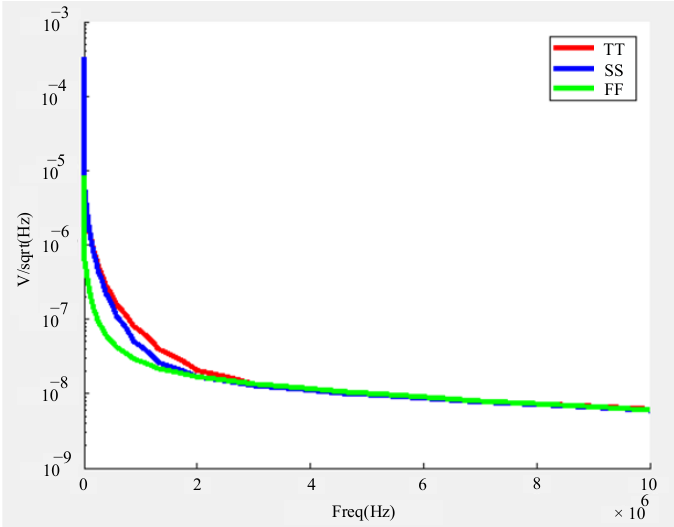
Figure 12. The output noise voltage of the proposed BGR circuit. Table 1. Performance under different process concerns of the proposed BGR circuit.